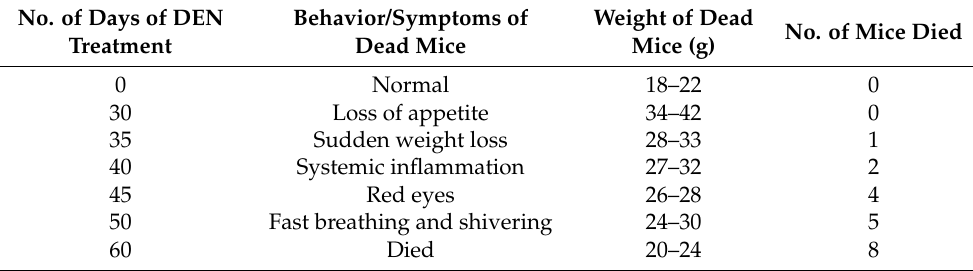
Table 2. Animal burden and weight loss upon application of DEN and CCl 4 in mice, who started dying on day 35 of carcinogenic chemical